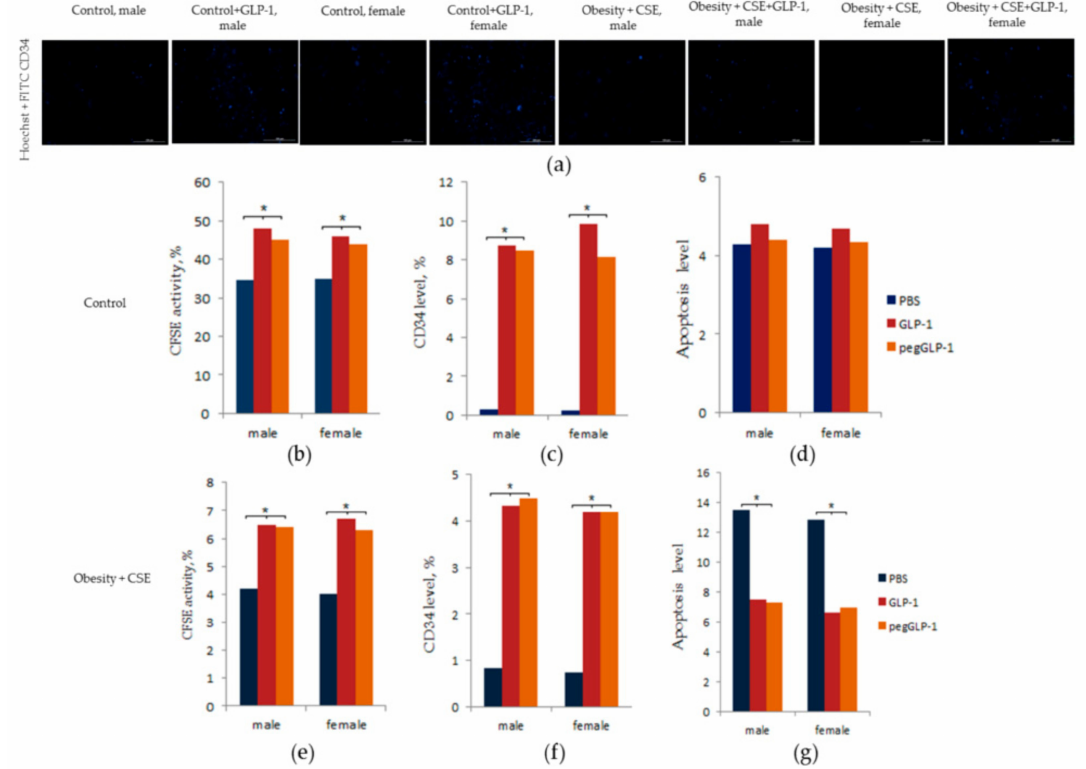
Figure 9. GLP-1 and pegGLP-1 treatment e ff ects on CD31 + endothelial cells isolated from the lungs of male and female C57BL / 6 mice in vitro: ( a ) Images of CD31 + cells stained with: Hoechst (blue) to identify cell nuclei; CD34 FITC (green) (Hoechst + CD34) composite image using all two colors. All scale bars are 100 µ m; ( b – g ) CD31 + endothelial cells from lung were precultured for 5 days, incubated with or without GLP-1 (10 − 7 M) or pegGLP-1 (10 − 7 M) for 24 h and then labeled with Hoechst, Carboxyfluorescein succinimidyl ester (CFSE) ( b , e ) CD34 FITC ( c , f ), Annexin V and 7-Aminoactinomycin D (7-AAD) ( d , g ) prior to fluorescence microscopic analysis. ( b ) CFSE activity after culture of cells isolated from the lung of intact mice; ( c ) the level of CD34 + cells after culture of cells isolated from the lung of intact mice; ( d ) the count of cells with apoptosis after culture of cells isolated from the lung of intact mice; ( e ) CFSE activity after culture of cells isolated from the lung of mice with MD and lung emphysema; ( f ) the level of CD34 + cells after culture of cells isolated from the lung of mice with MD and lung emphysema; ( g ) the count of cells with apoptosis after culture of cells isolated from the lung of mice with MD and lung emphysema. All data are expressed as mean ± SD, *—significance of di ff erence compared with control ( p <